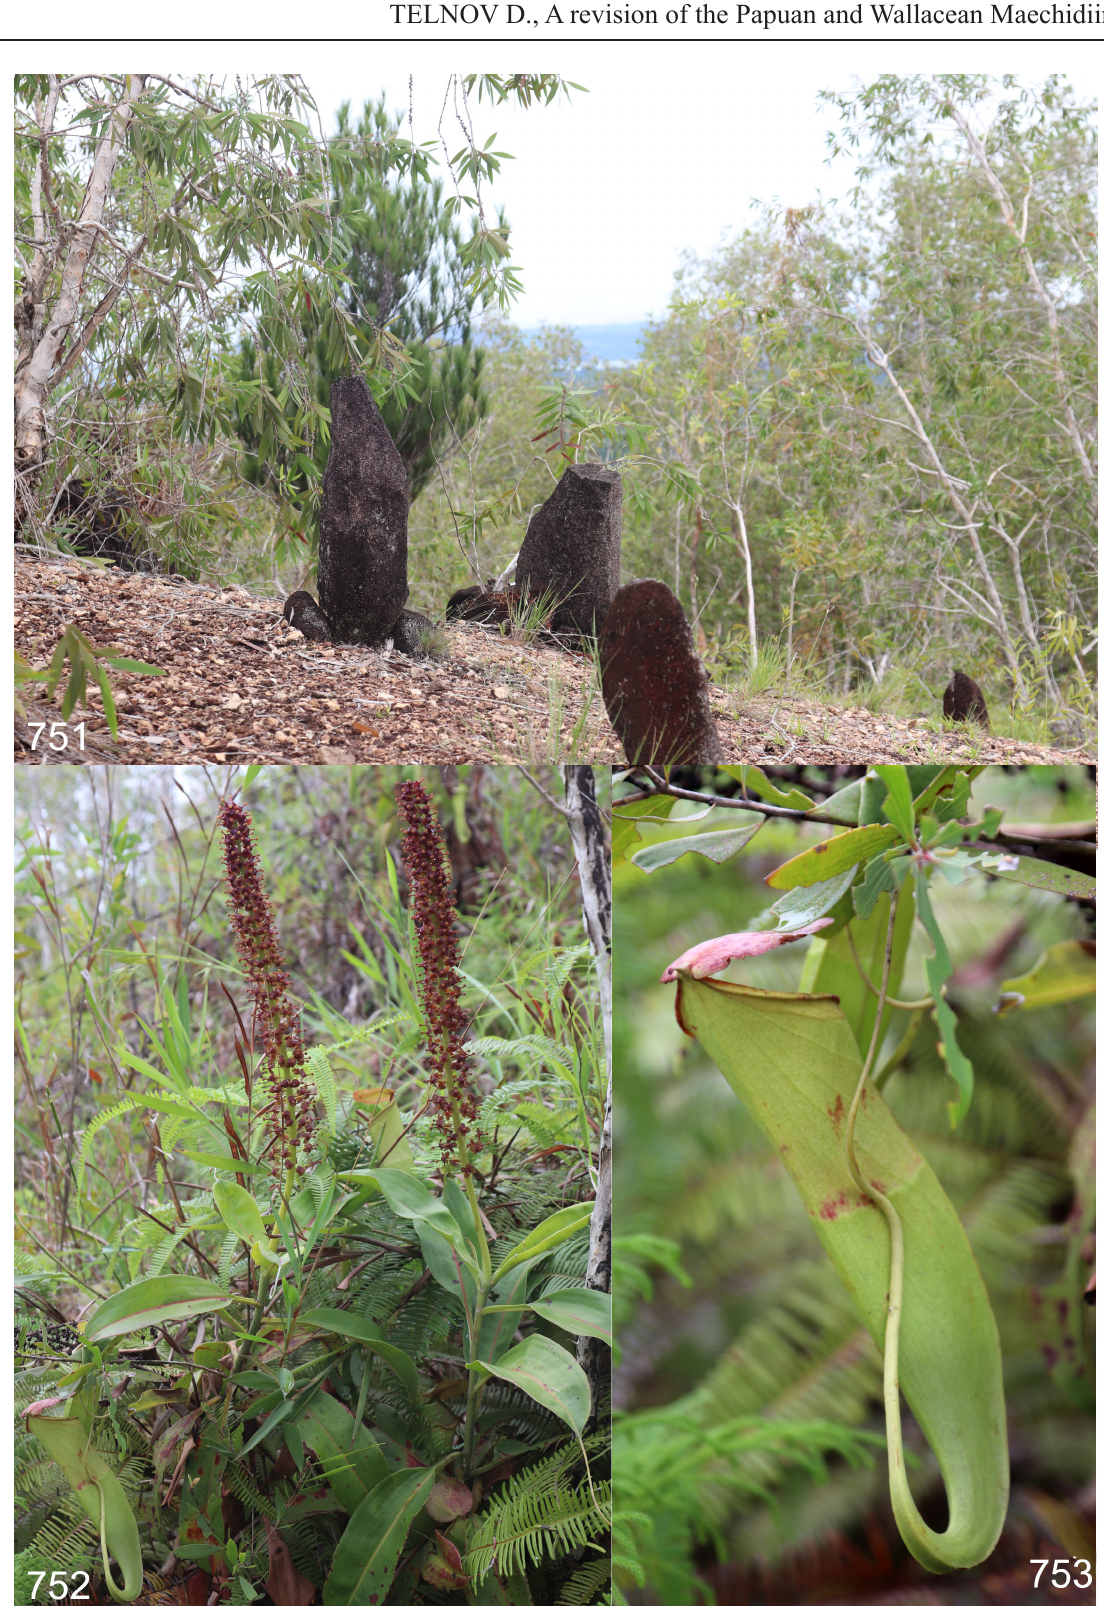
Figs 751–753. Dry nutrient-poor semi-dry slopes in eucalypt stands near Doyo Lama village, Sentani env., North New Guinea. Numerous Maechidius lobaticeps Frey, 1969 and the type series of M. nepenthephilus sp. nov. were sampled from flowers and pitchers of Nepenthes sp. in this